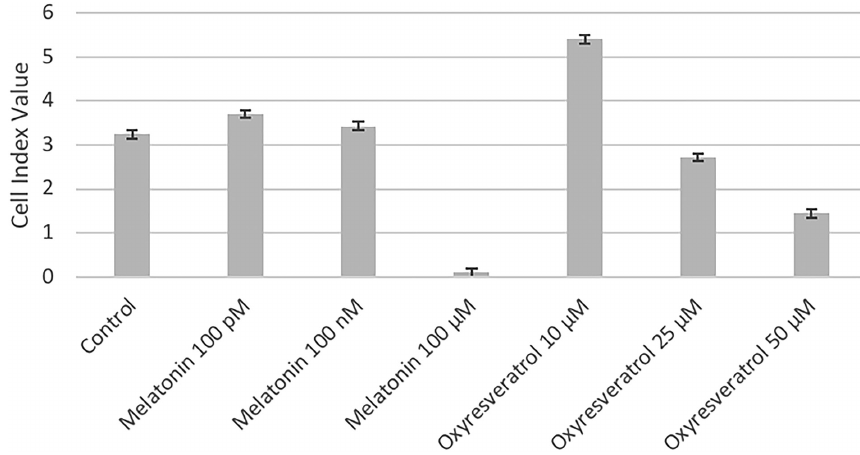
Figure 2. Estimated marginal means with 95% CIs of DPCSs’ cell index valuesas determined by ANCOVA at the 60th hour. All interactions between groups were significant ( P < .001) except for the difference between melatonin 100 nM and the control group. ANCOVA, analysis of covariance.